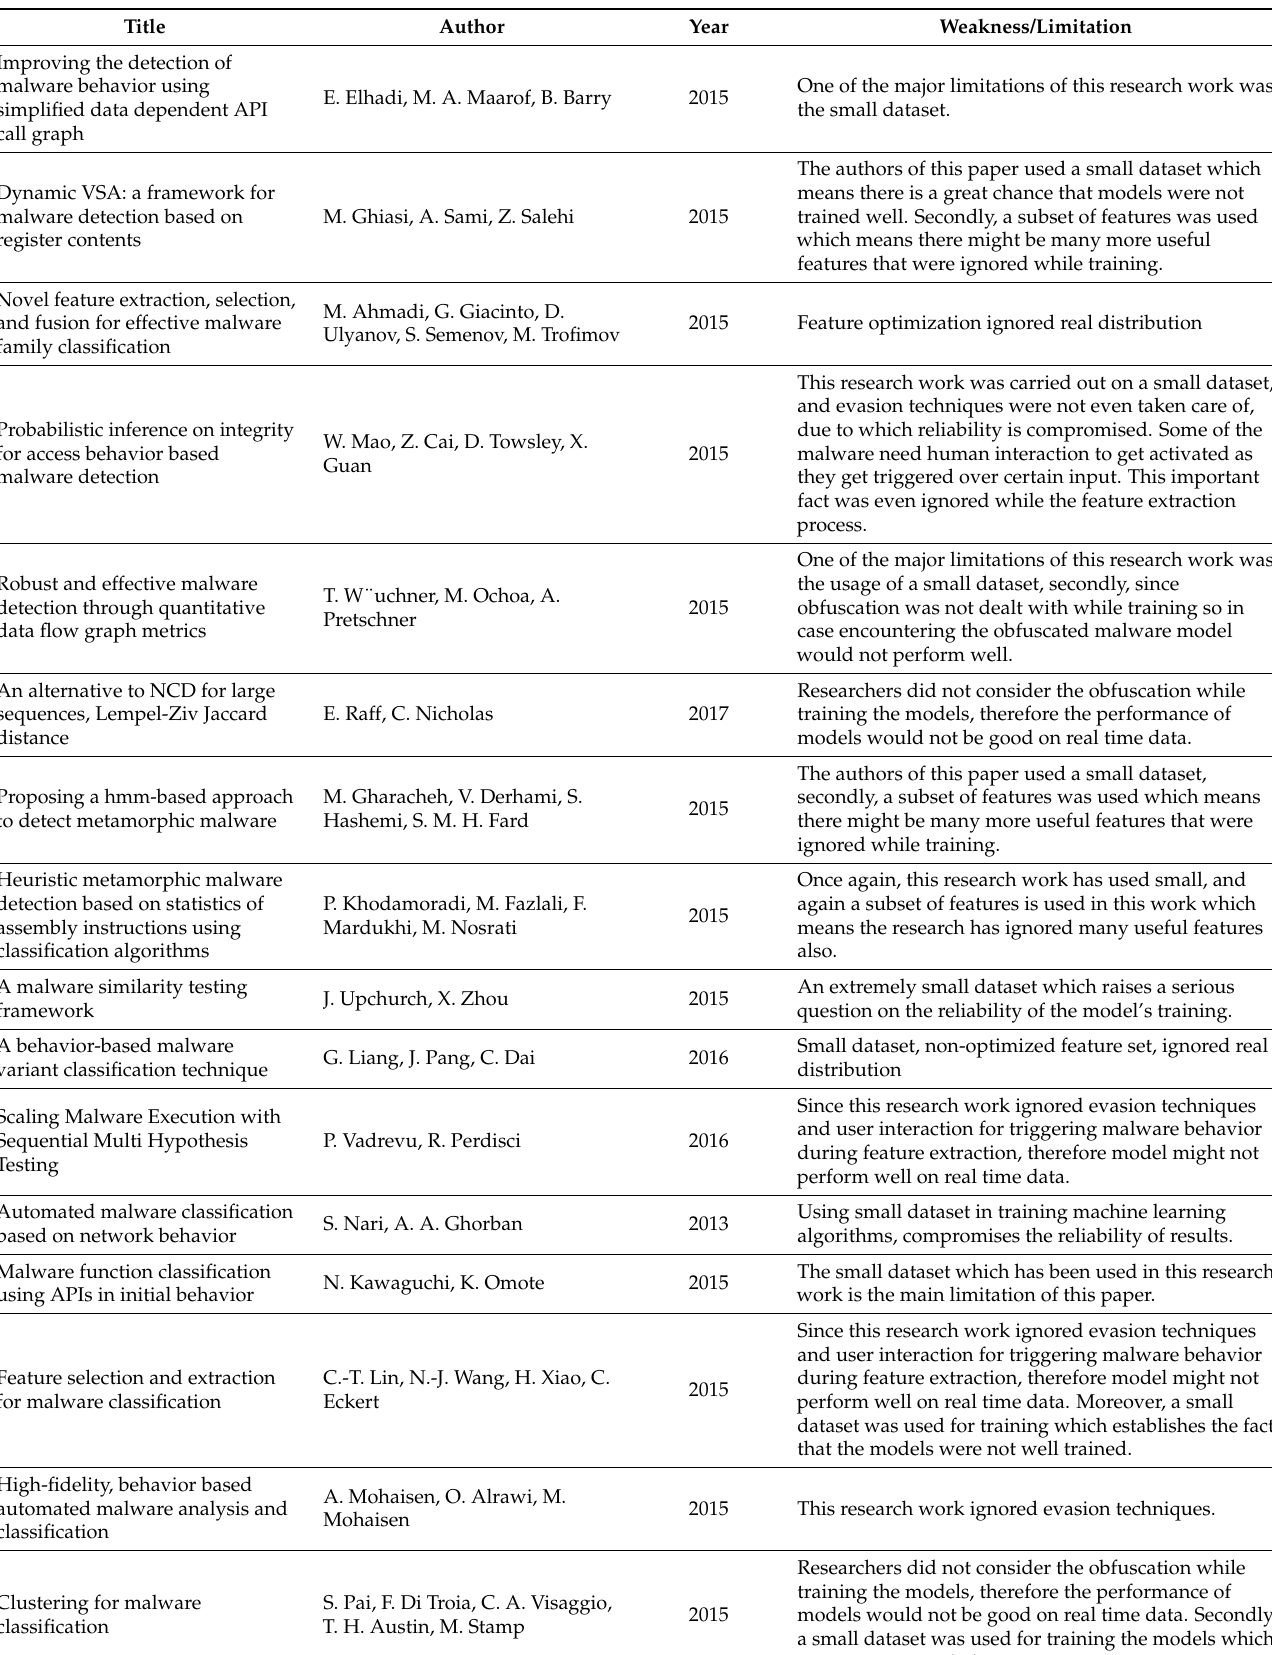
Table 5. Limitations of Surveyed Papers Proposing Machine Learning Based